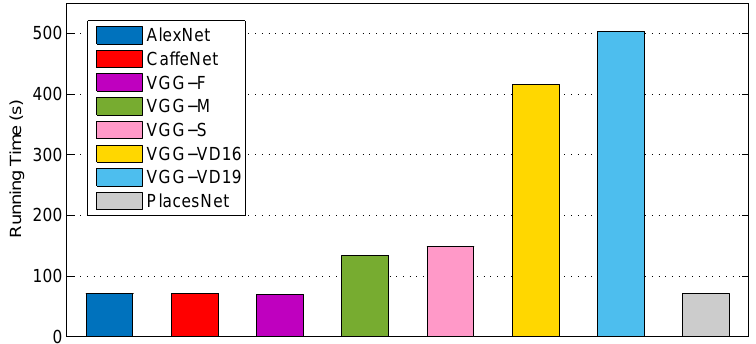
of a local region on feature maps from different convolutional layers, which are shown in Figure 8. We can see that the size of the receptive filled with respect to the input image becomes larger for the neurons on feature maps of deeper layers.